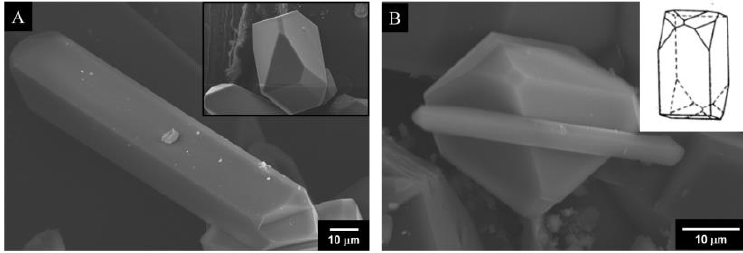
Figure 7. Representative SEM images of compound 1 showing its typical crystal sizes ( A and B ,